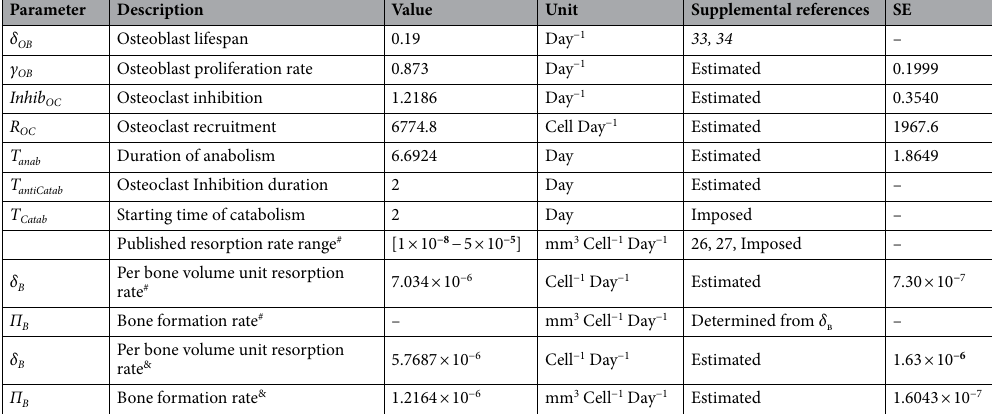
Table 1. Parameters extracted from published literature were combined with temporal dynamics data in ODE model to estimate previously unknown parameters needed to fit bone data. Apposition rates from confined model (#) were calculated in fashion to offset resorption rates derived from publication, to maintain constant bone volume at